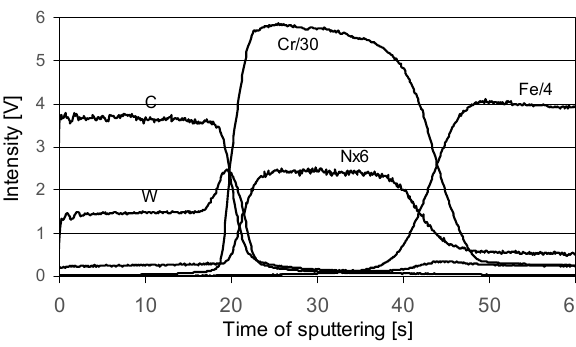
Figure 3. GDOES depth profile of the W ‐ DLC/CrN coating.